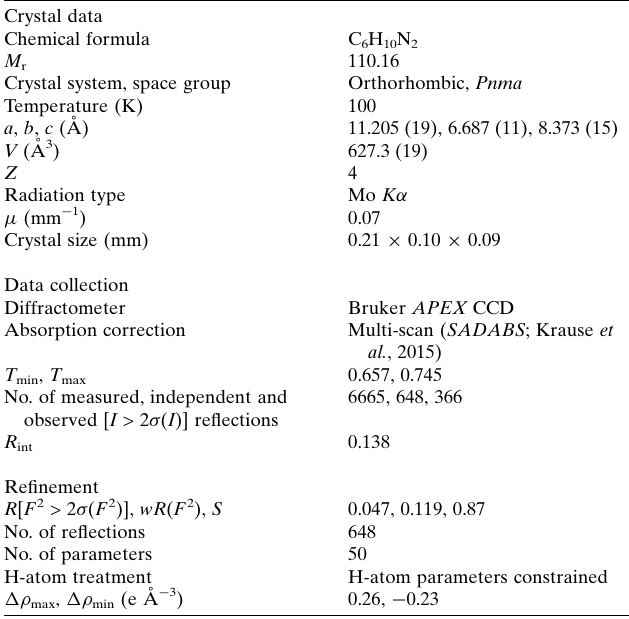
Table 4 Experimental details. Crystal data Chemical